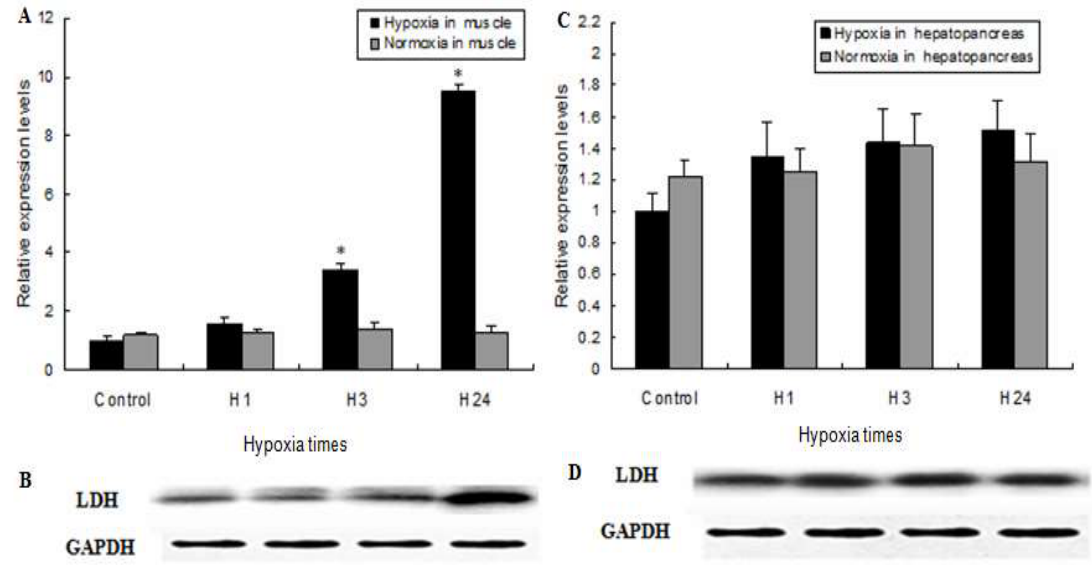
Figure 6. LDH mRNA and protein abundance in muscle ( A , B ) and hepatopancreas ( C , D ) from M. nipponense exposed to hypoxia. (*) indicates significant differences ( p < 0.05) between the normoxia and hypoxia groups. Vertical bars represent mean ± SEM values for triplicate samples.